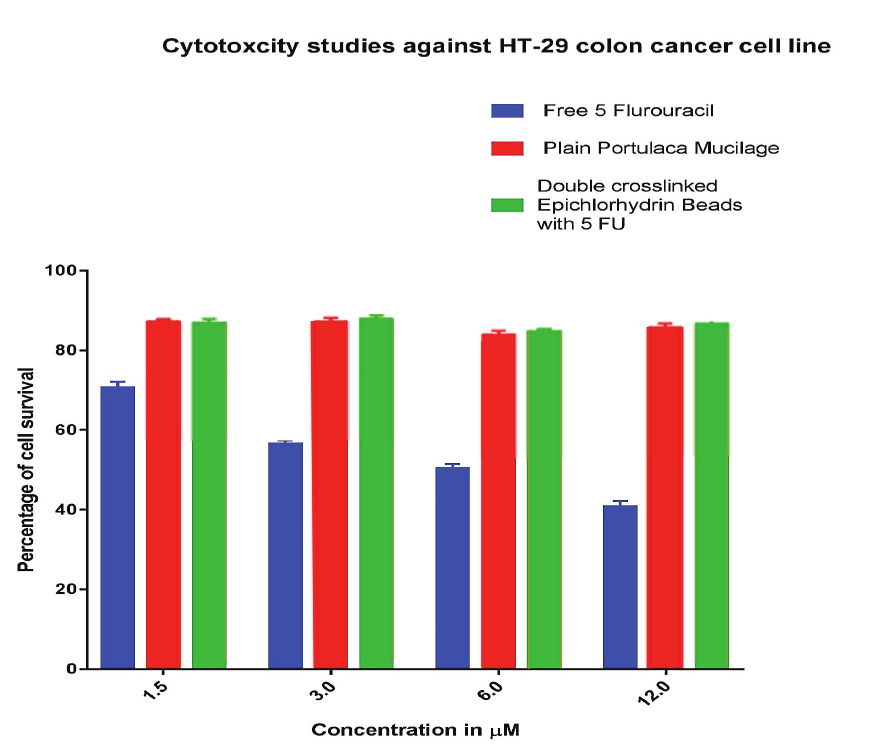
Figure 2: Cytotoxicity evaluation of the anticancer drug 5-FU, Portulaca mucilage and drug-loaded hydrogel bead formulation using a colon cancer cell line